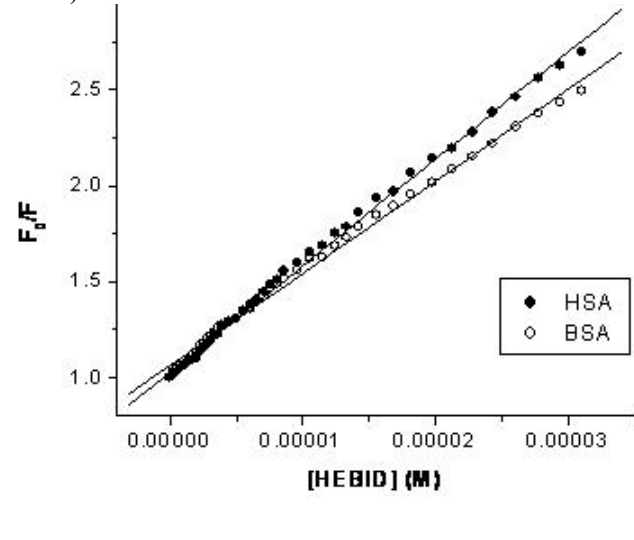
Figure 2 . Stern-Volmer plots for the quenching of HSA and BSA by HEBID in the d/p range 0-10. F and F denote the fluorescence intensities in the absence and presence of the 0 quencher ( λ = 286 ex